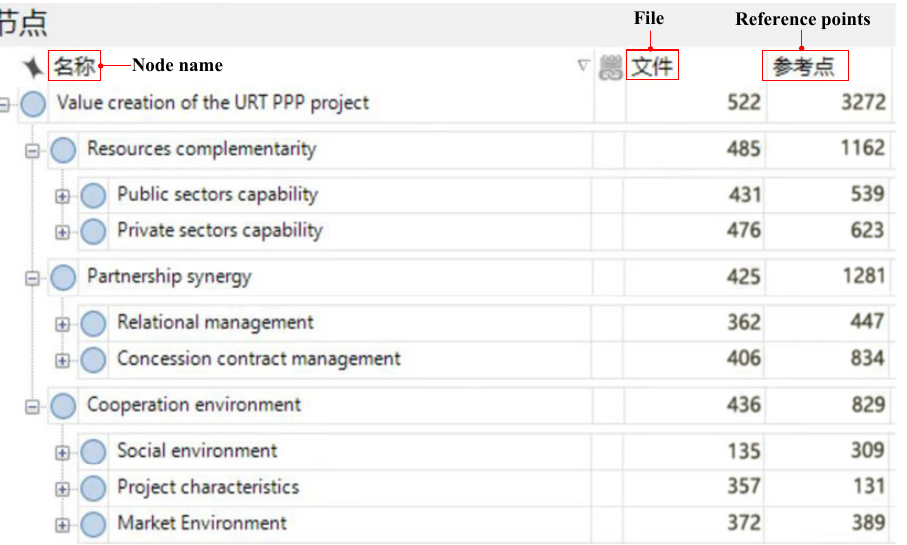
Figure 3. Axial coding